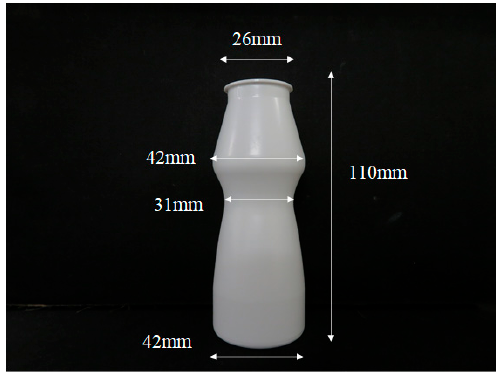
Figure 2. Image of the container.